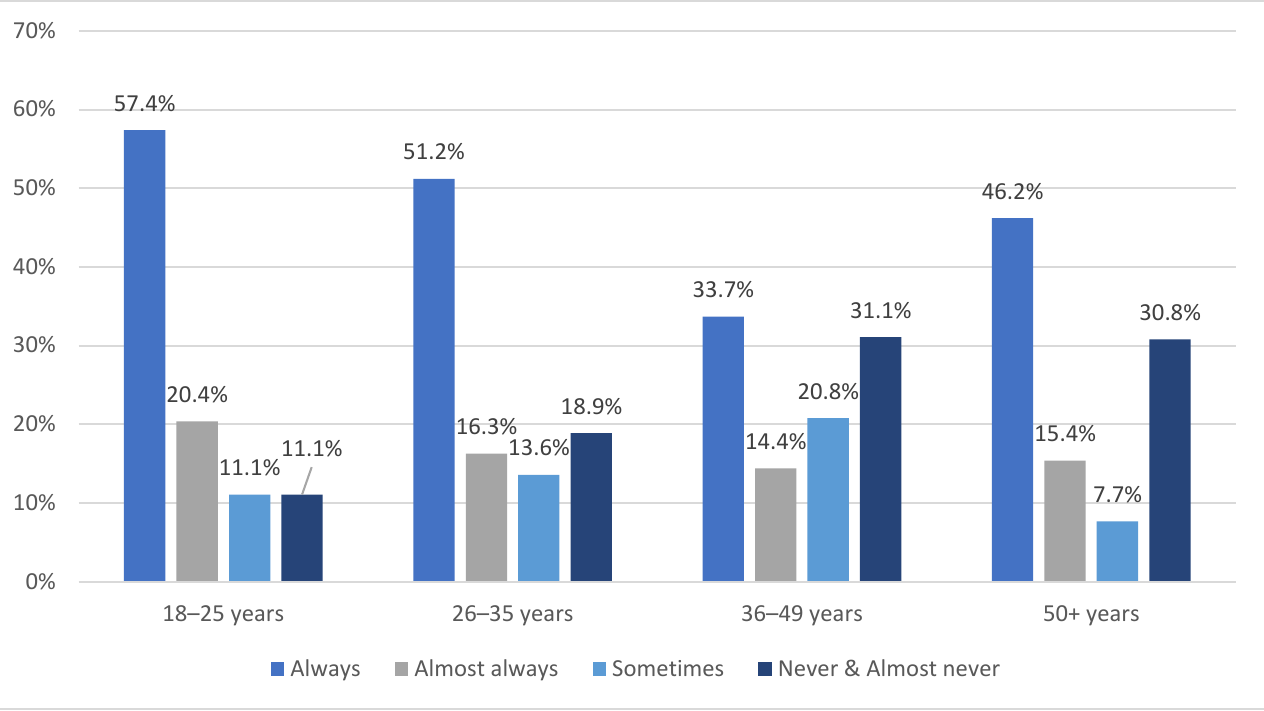
Table 3. Participants’ gender and frequency of restraint use for their eldest child while travelling in a motor vehicle. Table 4. Participants’ education level and frequency of restraint use for their eldest